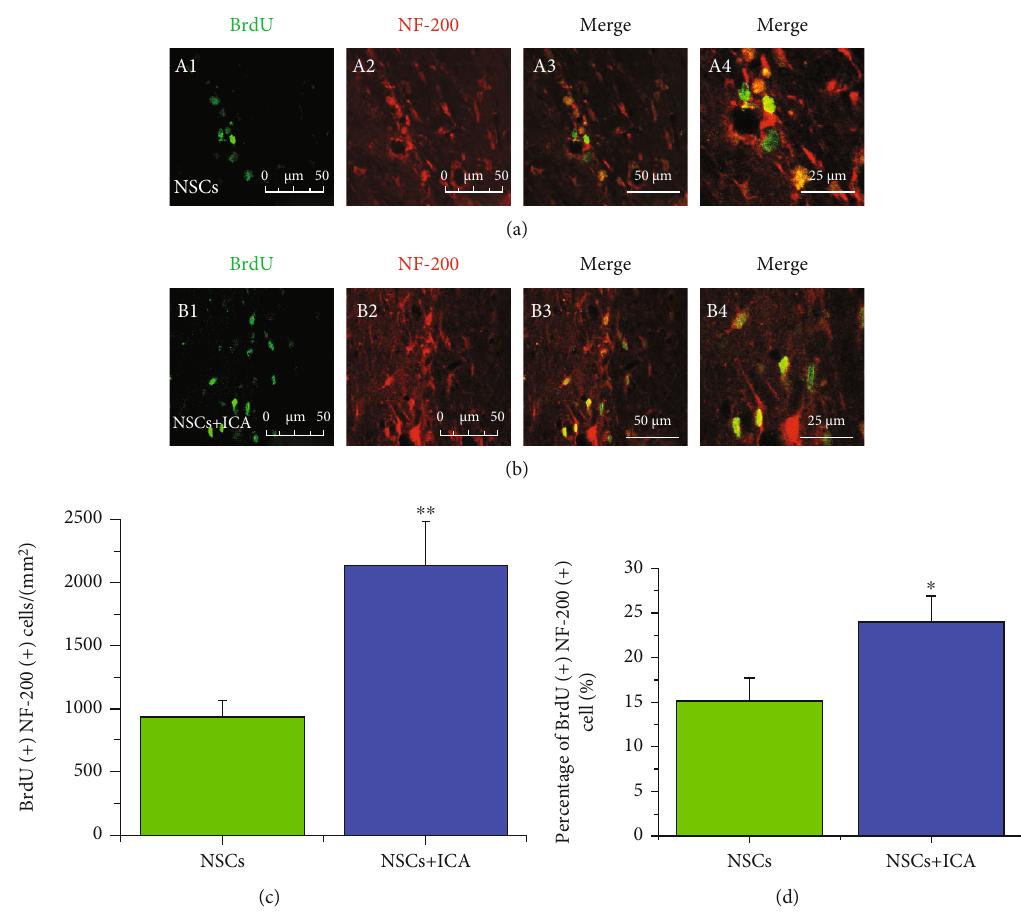
Figure 4: ICA treatment promotes transplanted NSCs di ff erentiated into neurons in the FFT rat model. Double immuno fl uorescent staining of BrdU and NF-200 was applied to detect the number of neurons di ff erentiated from NSCs of the NSC transplantation group (a) and NSC + ICA group (b). Scale bar = 50 μ m (A1 – 3, B1 – 3); 25 μ m (A4, B4). (c) Quantitative analysis of the number of NF-200(+)- and BrdU(+)-positive cells in vivo . (d) Quantitative analysis of the percentage of BrdU(+)/NF200(+) cells to BrdU(+) cells in vivo . Data are expressed as the mean ± SEM , n = 3 . ∗ P < 0 : 05 and ∗∗ P < 0 : 01 , the NSC + ICA group vs the NSC transplantation